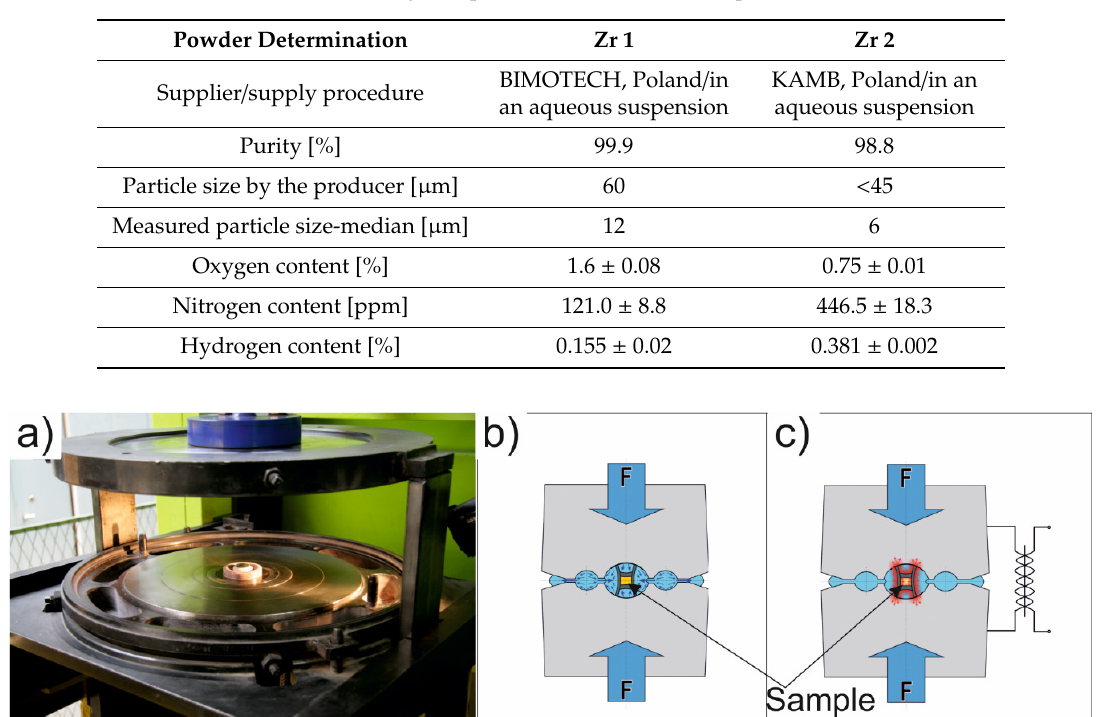
Table 1. Purity and particle sizes of zirconium